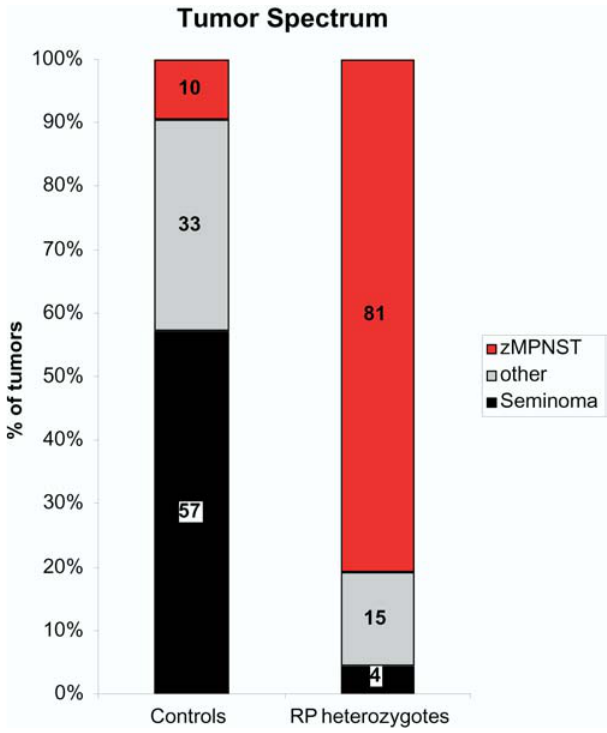
Figure 2. The Tumor Spectrum in Fish Heterozygous for Mutations in RP Genes Shows an Increased Proportion of zMPNSTs Fish with apparent masses were selected and processed for histological analysis. Numbers are shown as percent of the total number of diagnosed tumors from either population. The control group includes 42 tumors from 41 fish, including both wild-type and non-RP family transgenics. The RP group includes 68 tumors from 65 RP heterozygotes from 18 different lines representing mutations in 16 different genes. The ‘‘ other ’’ tumor category includes pancreatic islet adenomas, ultimobranchial gland tumors, neuroblastomas, retinoblastomas, lymphomas, ganglioneuromas, ductal carcinomas, gastrointestinal adenocarcinomas, hepatocellular carcinomas, leuke- mias, meningiomas, and histiocytic sarcomas. DOI: